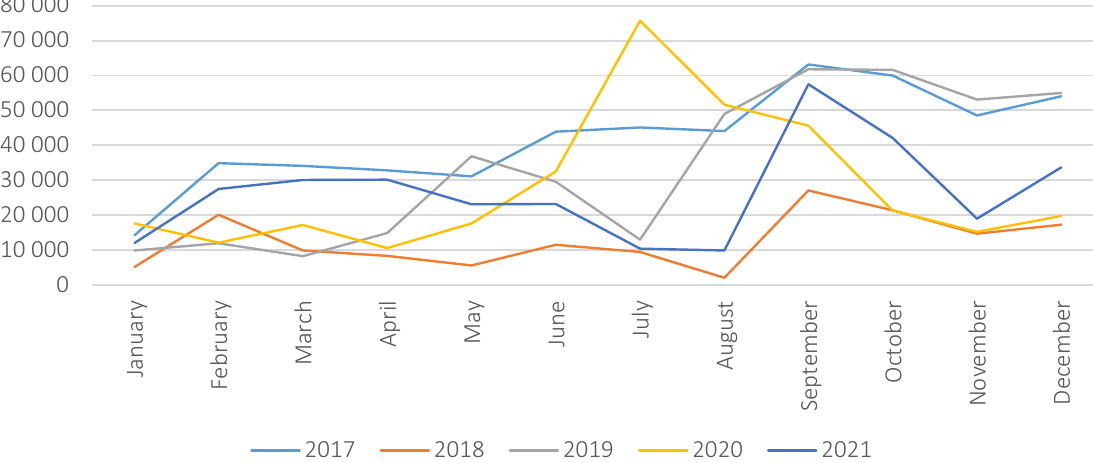
Figure 1. TSA opening balance (as of the beginning of each month) in 2017–2021, UAH million